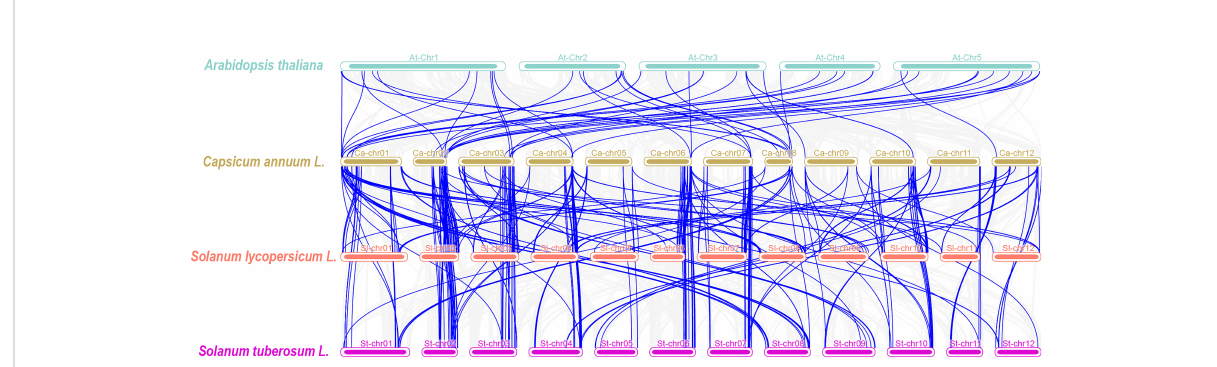
FIGURE 4 Synteny analyses between the CYP genes of pepper and three plant species. The gray lines in the background indicate collinear blocks within the capsicum genome and other three plant species genomes, while the blue lines highlight syntenic CYP gene